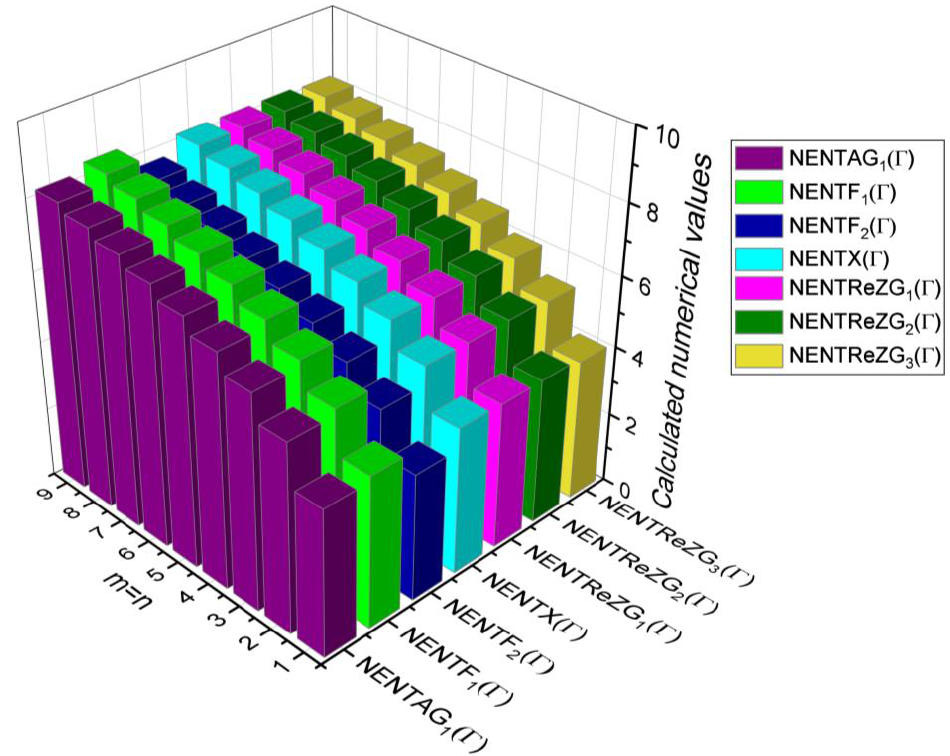
Figure 11. 3D plots for Table 10.